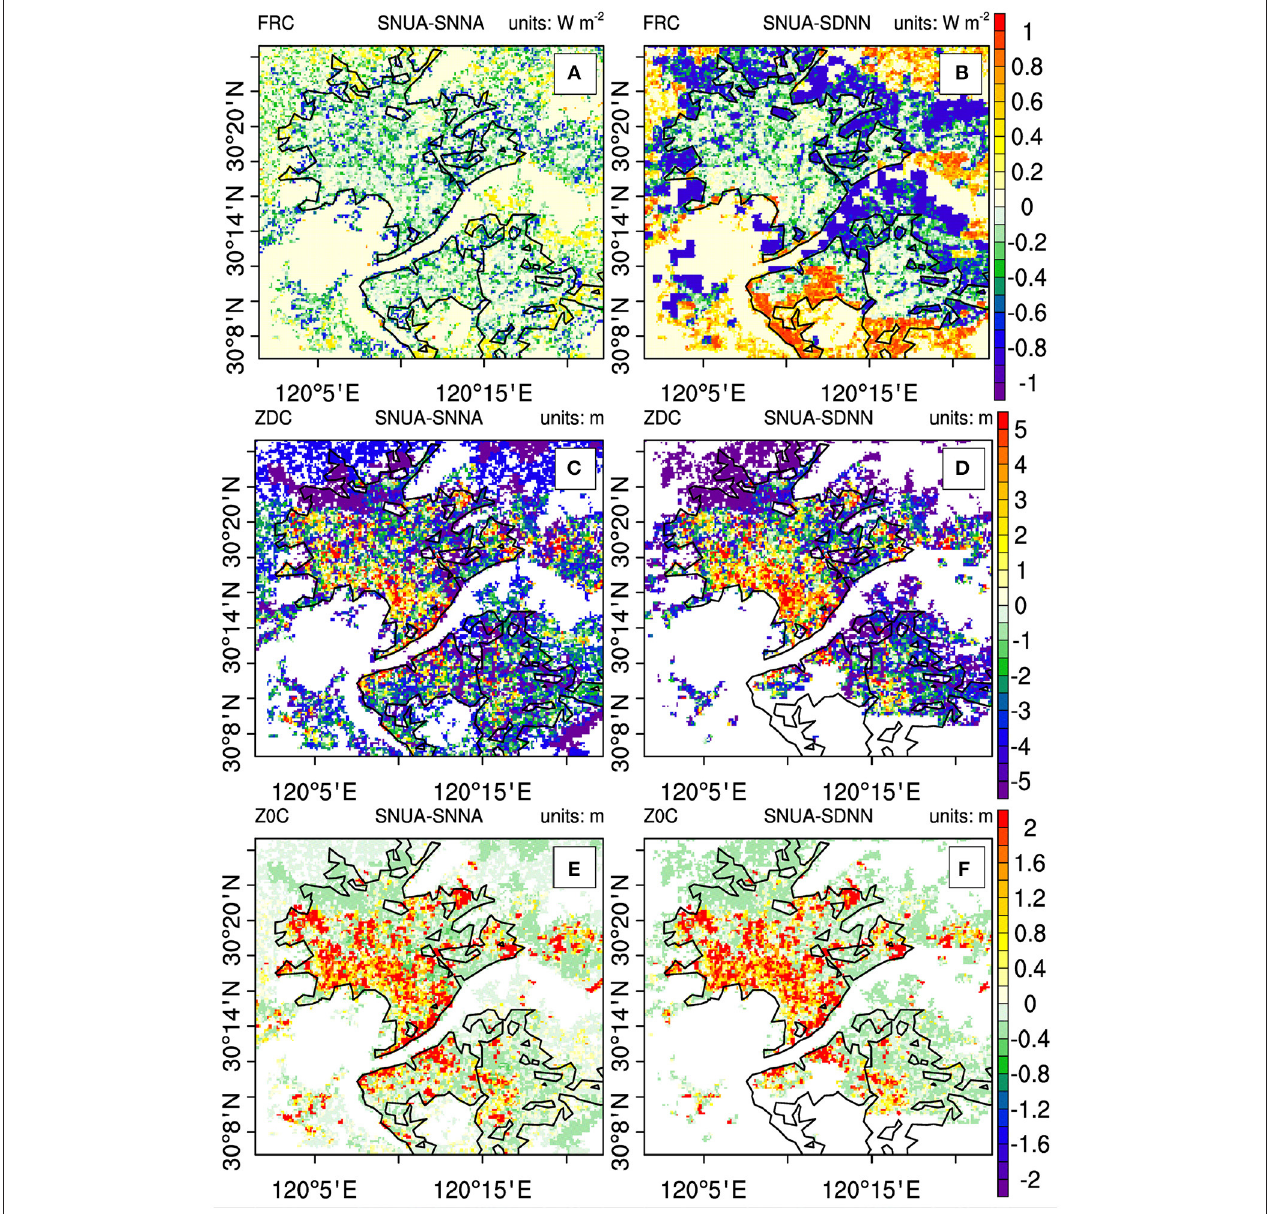
FIGURE 11 | The difference in (A,B) impervious fraction (unitless), (C,D) zero plane displacement height (m), (E,F) roughness length above canyon (m) between SNUA run and SNNA (A,C,E) and SNUA run and SDNN run (B,D,F)